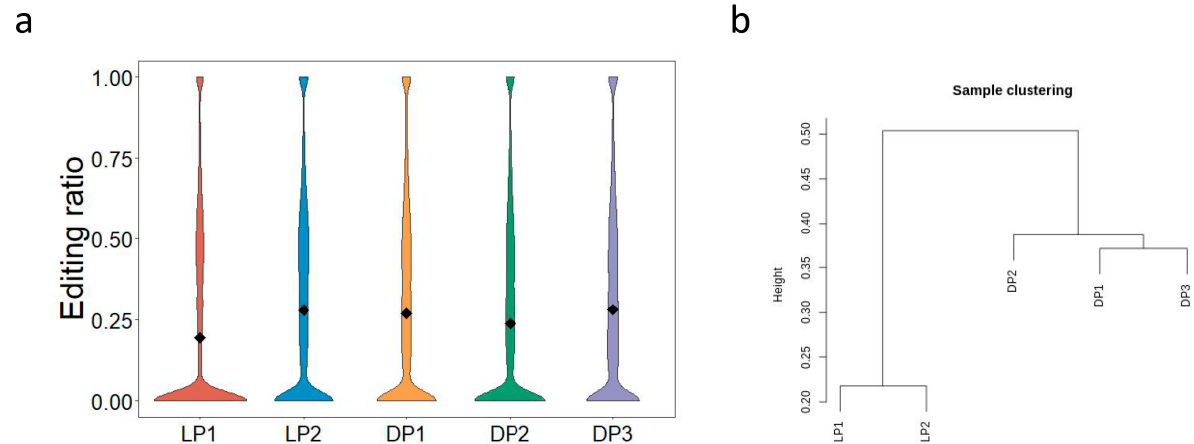
Figure 4. Features of RNA editing levels within and between groups. ( a ) The violin plot of editing levels across samples. ( b ) Hierarchical clustering of RNA editing levels across five samples.